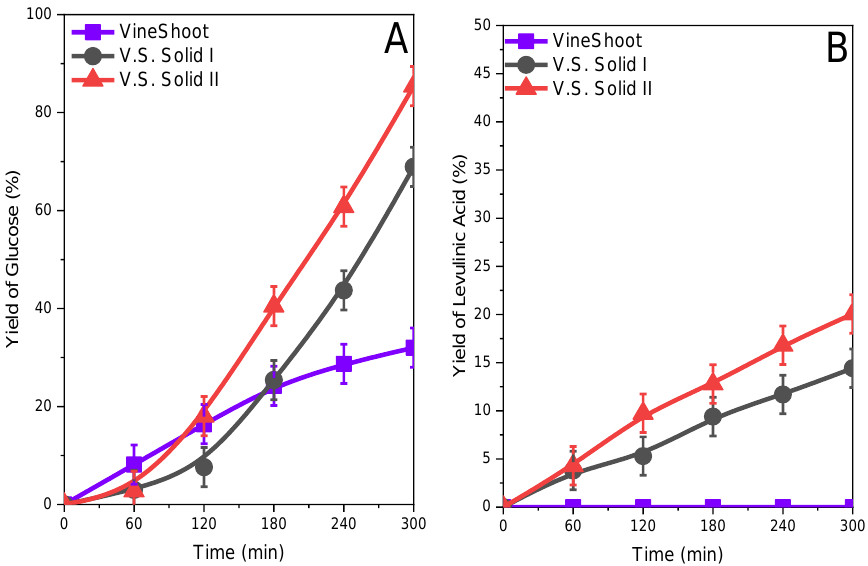
Figure 8. Glucose ( Graph A ) and levulinic acid ( Graph B ) yields after the hydrolysis of the original vine shoots and vine shoot solids obtained (Solid I and Solid II) after treatment with ISH. In addition to glucose and xylose, in the hydrolysis process, oligomers with soluble units are obtained due to the breaking of the polymer chains of cellulose and hemicellulose into smaller fragments. For this reason, the final reaction liquid was analyzed (after 5 h of reaction) and the content of total reducing sugars (TRS) was calculated. The obtained results are shown in Table 6, where Solid I and Solid II are compared with their corresponding untreated biomasses. The TRS values are higher than the TRS values obtained after the sum of monomeric sugars provided by the HPLC analysis, showing that there were some oligomers in the reaction medium. This result disagrees with the data from the untreated biomass samples in all cases.